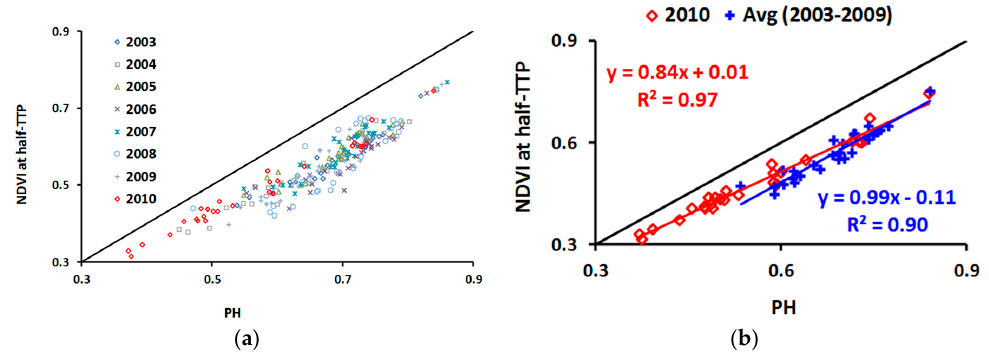
Figure 15. Scatter plots of: ( a ) NDVI at half-TTP as a function of PH NDVI derived from a CxQ model for the 2010 heatwave affecting Russia and Kazakhstan; and ( b ) the 2010 data and the average data for the rest of the years (2003–2009). Note in ( a ) the position of the 2010 phenometrics presented by red diamonds relative to the other years in their respective sites. Note also the 2010 marker for the upper-right corner, which is for the MFO site in Mari El, Russia.